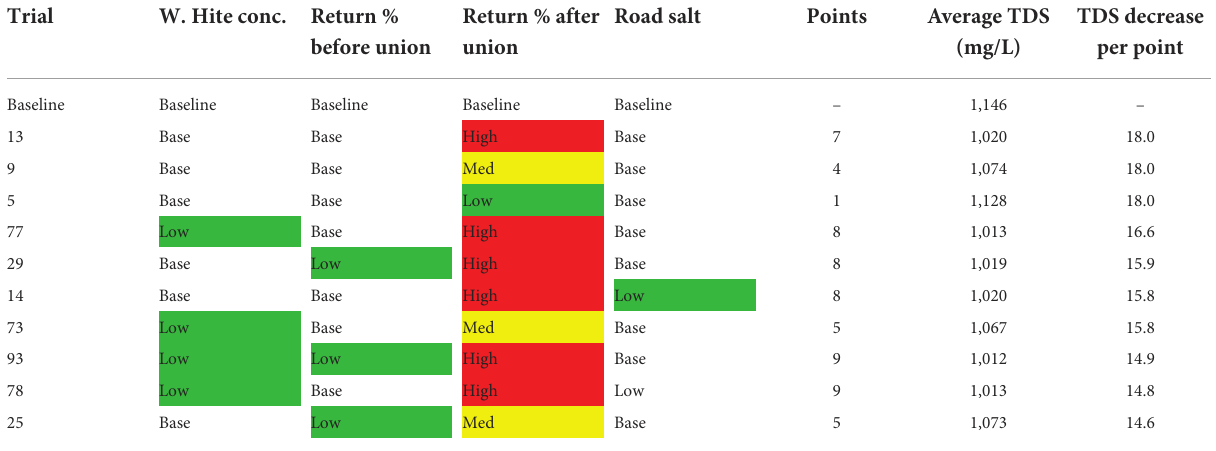
TABLE 3 Top 10 efficient agricultural salt management trials for the months April–October.